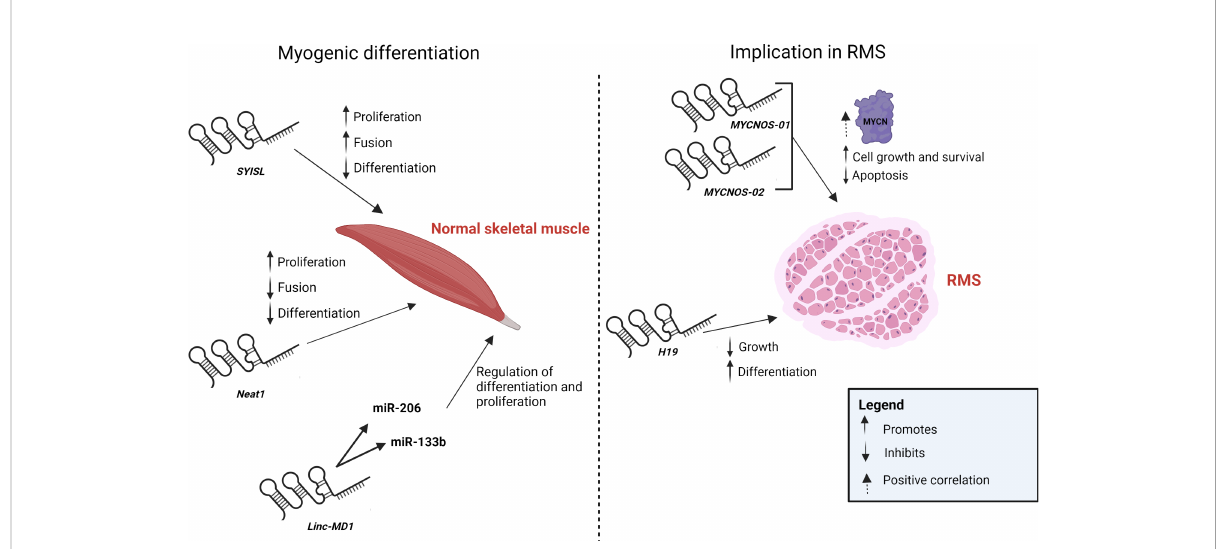
FIGURE 3 LncRNA implication in skeletal muscle myogenesis and RMS. Schematic diagram of lncRNA SYISL , Neat1 and Linc-MD1 implicated in skeletal muscle differentiation and proliferation (left panel) and lncRNA MYCNOS-01 , MYCNOS-02 and H19 implicated in RMS proliferation biology (right panel). Created with